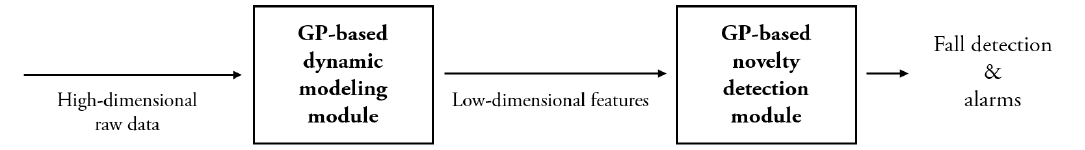
Figure 3. Seamless combination of GP-based walking representation and fall detection.